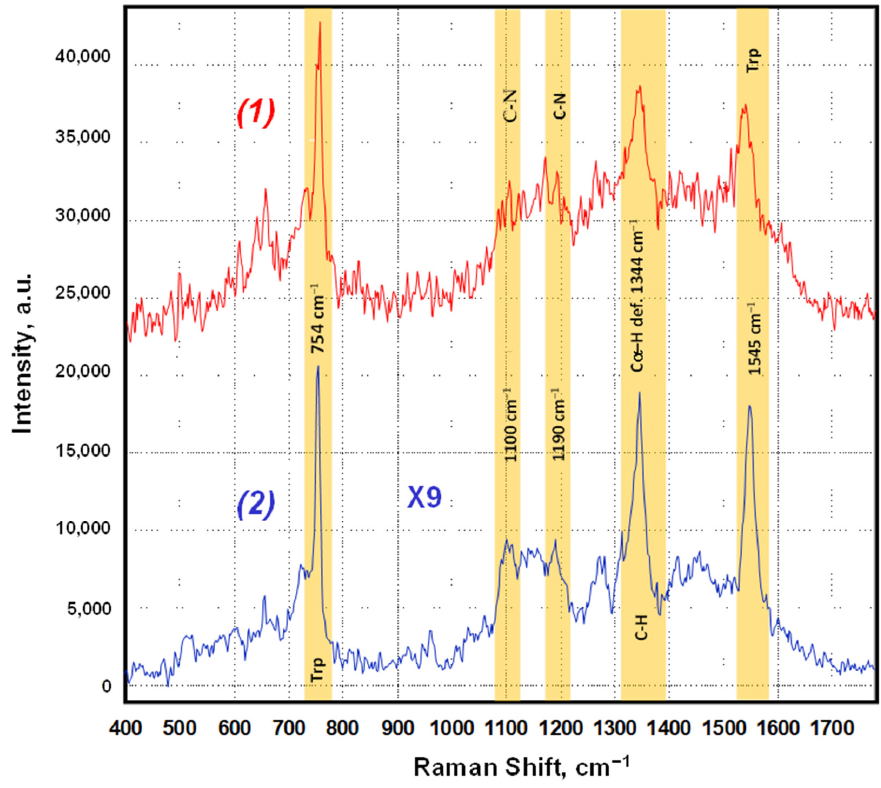
Figure 8. Changes in the degree of enhancement of the Raman scattering spectrum of a sample of the RBD of the SARS-CoV-2 S glycoprotein with reactive thiol groups upon application of a thin silver film onto the protein sample bound with the SERS-active substrate. (1) The SERS spectrum of the RBD upon additional application of a thin silver film onto the protein sample bound to the sur- face of the SERS-active substrate. The spectrum is not normalized. (2) The SERS spectrum of the RBD without additional application of a thin silver film onto the protein sample bound to the surface of the SERS-active substrate. The normalization factor for the tryptophan residue band at about 755 cm − 1 is 9.0.